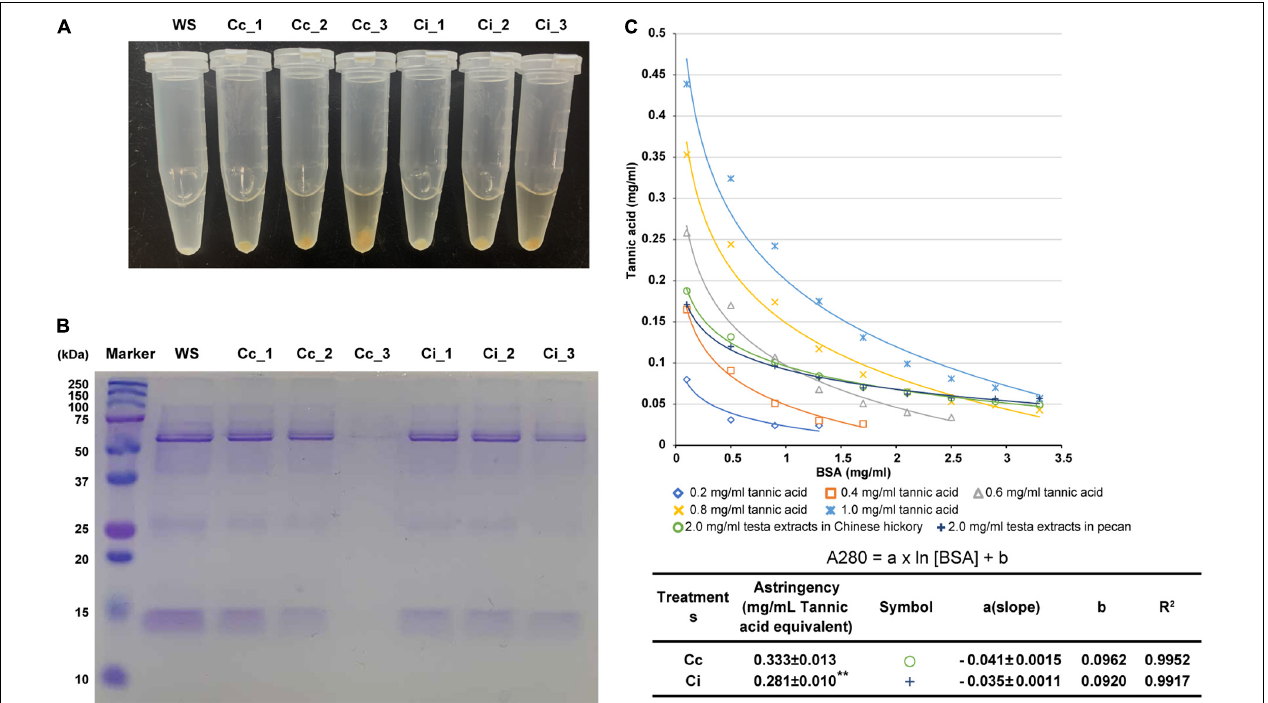
FIGURE 9 | Astringency assessment in the seed coats of Chinese hickory and pecan. (A) The difference of precipitate binding by human salivary proteins and the astringent substance in seed coat extracts. WS, salivary protein profile obtained for whole saliva; Cc_1-Cc_3, the residual protein in the supernatant after reaction of saliva and the three concentrations (0.625, 1.25, and 2.5 mg/ml) of mature seed coat extracts in Chinese hickory; Ci_1-Ci_3, the residual protein in the supernatant after reaction of saliva and the three concentrations (0.625, 1.25, and 2.5 mg/ml) of mature seed coat extracts in pecan. (B) SDS-PAGE gel electrophoresis of human salivary proteins in the supernatant of reactions. (C) Influence of serum albumin (BSA) additions on A280 nm from different tannic acid solutions and seed coat extracts. Cc: seed coat extracts in Chinese hickory; Ci: seed coat extracts in pecan. Data were expressed as mean ± SD ( n = 3). The asterisk stands for significant difference ( p < 0.01) in astringency between Chinese hickory and